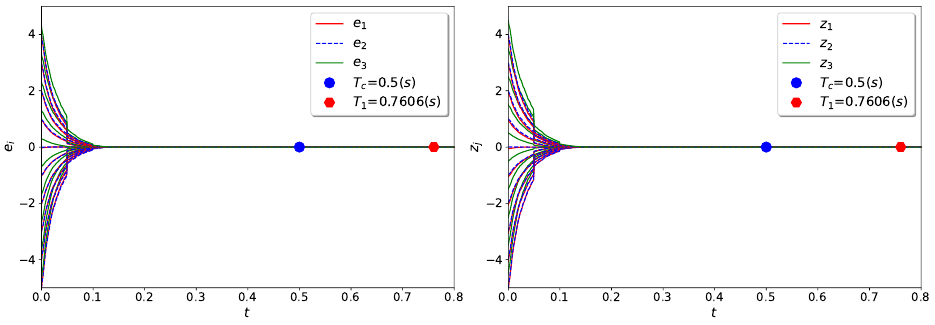
Figure 6. Evaluation of synchronization errors for Example 3.